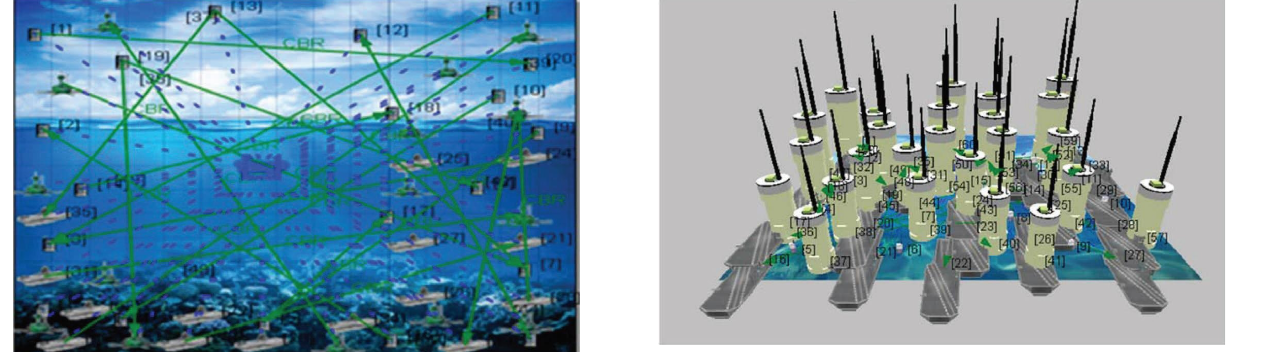
Figure 2: 3D visualization of underwater wireless